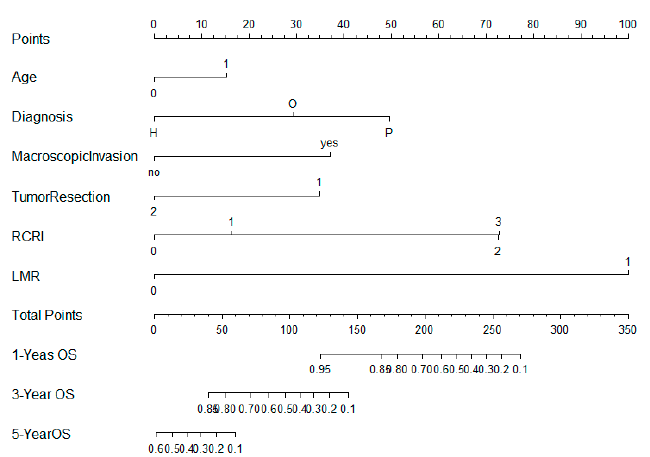
Figure 2. Nomogram for predicting overall survival using the multivariate Cox model.